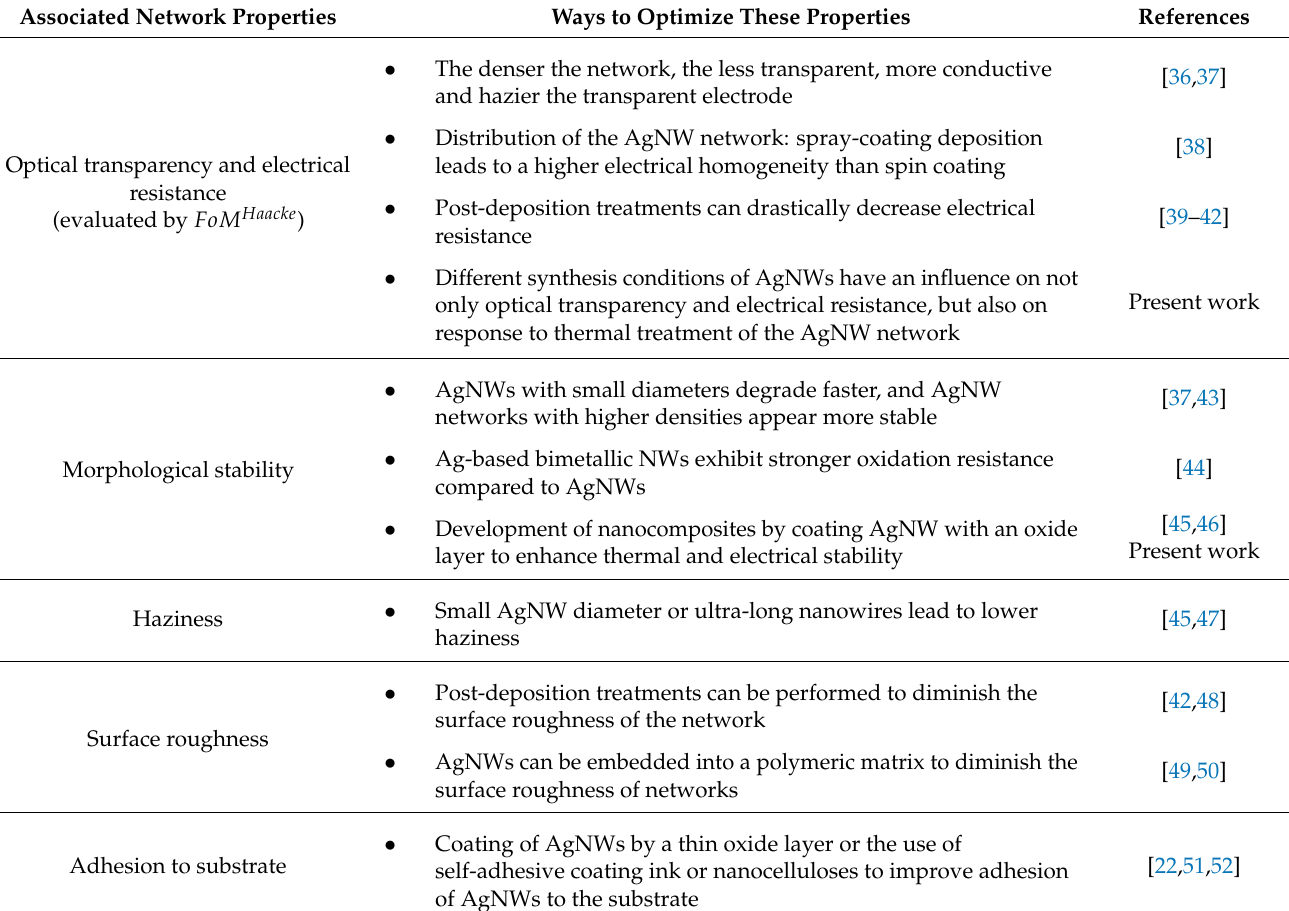
Table 2. Overview of the main properties of AgNW networks and recent ways to optimize these physical properties. Associated Network Properties Ways to Optimize These